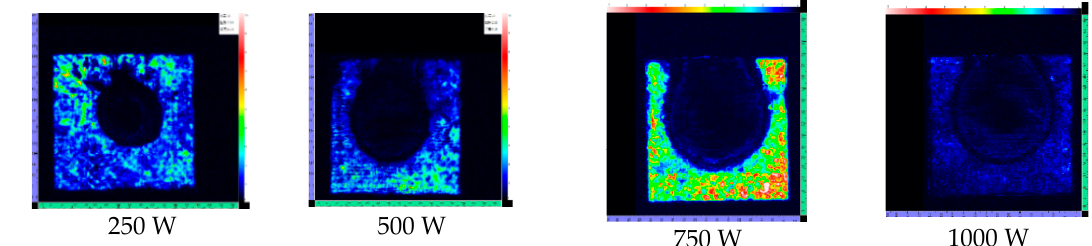
Figure 8. C-Scan images of CFRP laminates at different laser power.